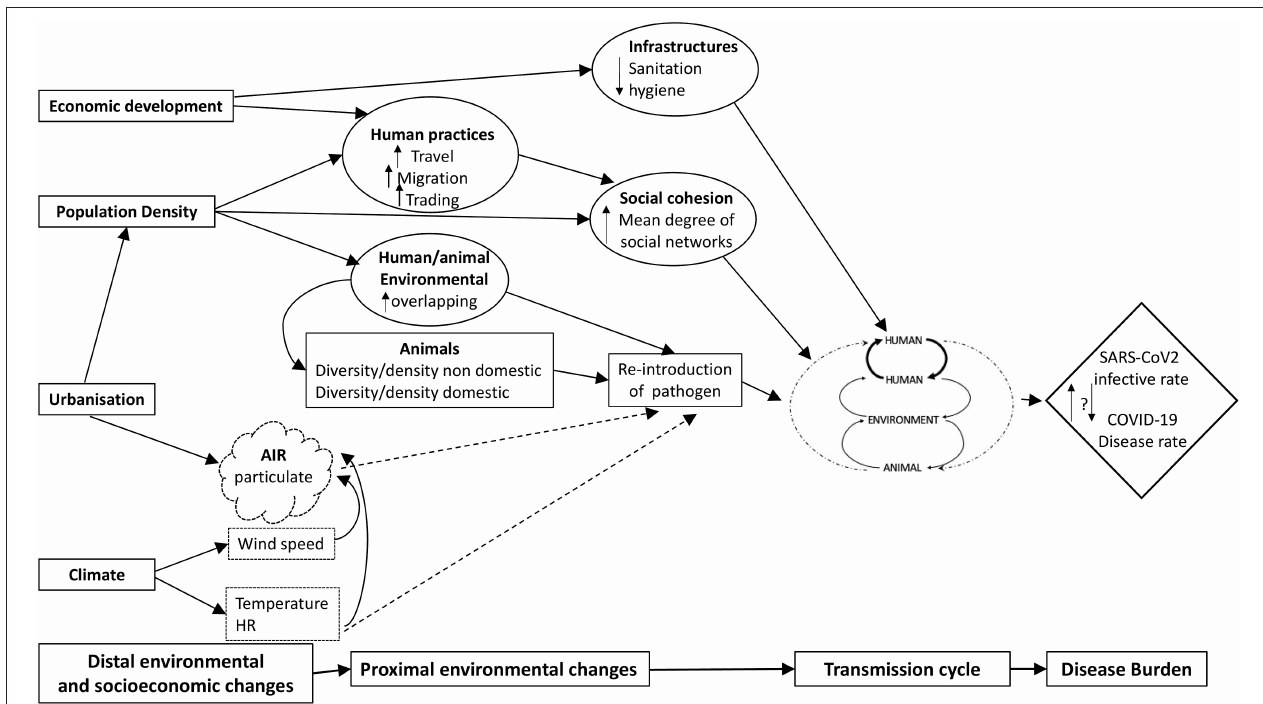
FIGURE 2 | Causal EnvID diagram showing the relationship between distal and proximal environmental changes and COVID-19 disease burden. Solid lines indicate actual influence and scattered lines represent potential influence.